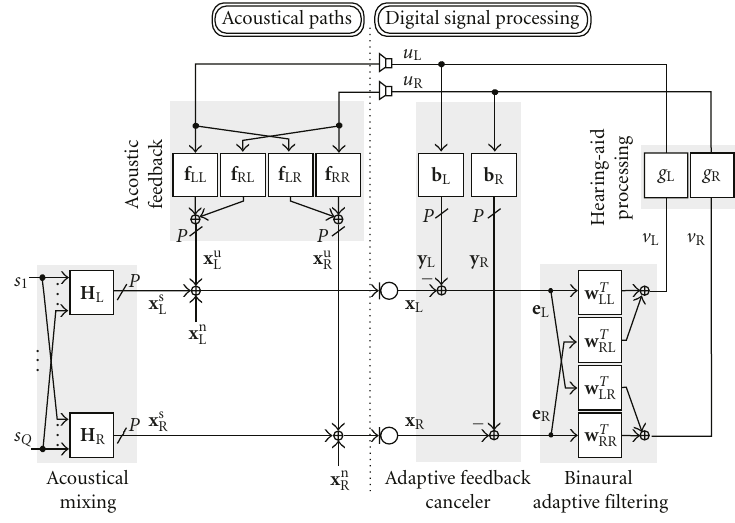
s tar refers to the target source and s int is a subset of s capturing the Q − 1 remaining interfering sources. h tar is a row of H which captures the transfer functions from the target source to the sensors and H int is a matrix containing the remaining Q − 1 rows of H . Like the other vectors and matrices defined above, these four entities can be further decomposed into their left and right subsets, labeled with the indices L and R, respectively. 2.3. The AFC Processing. As can be seen from Figure 1, we in the sensor signals, before passing them to the BAF. Feed- back cancellation is achieved by trying to produce replicas of these undesired components, using a set of adaptive